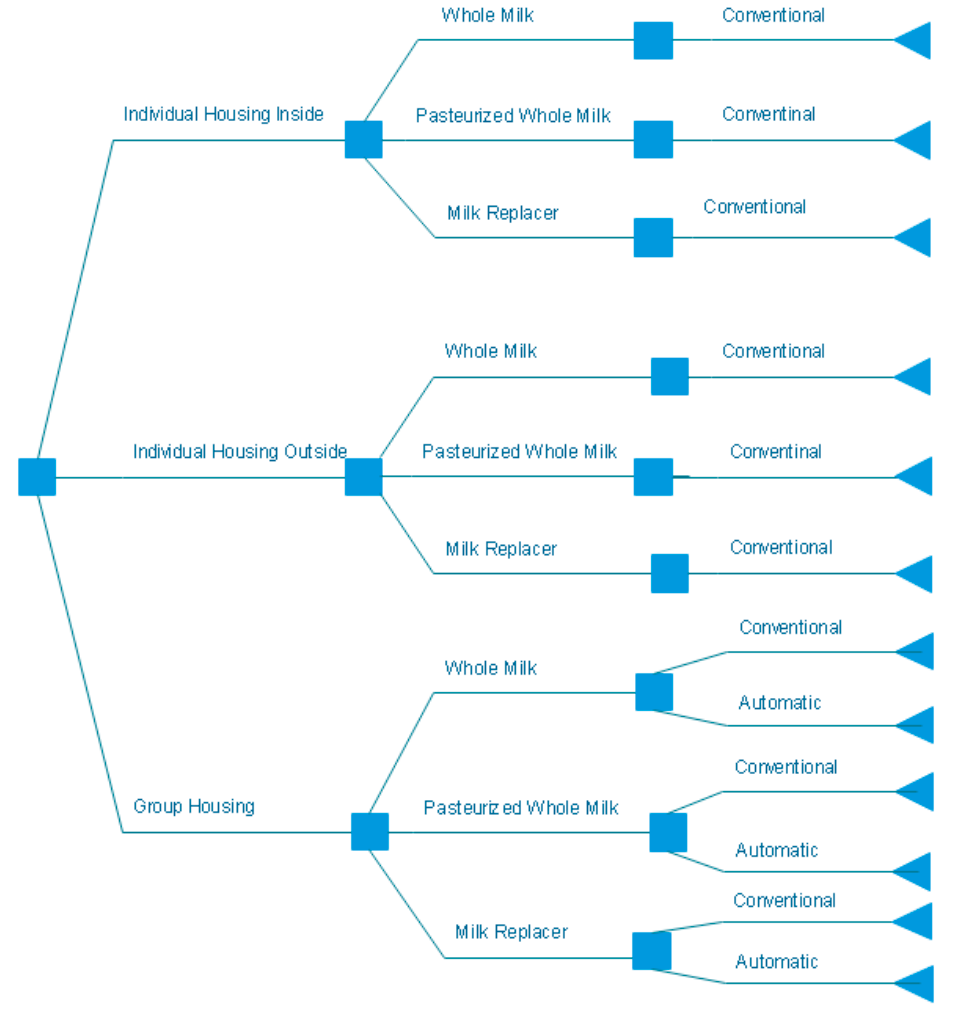
Figure 1. Decision tree of possible management decisions for housing, milk source, and labor for pre-weaned calves.